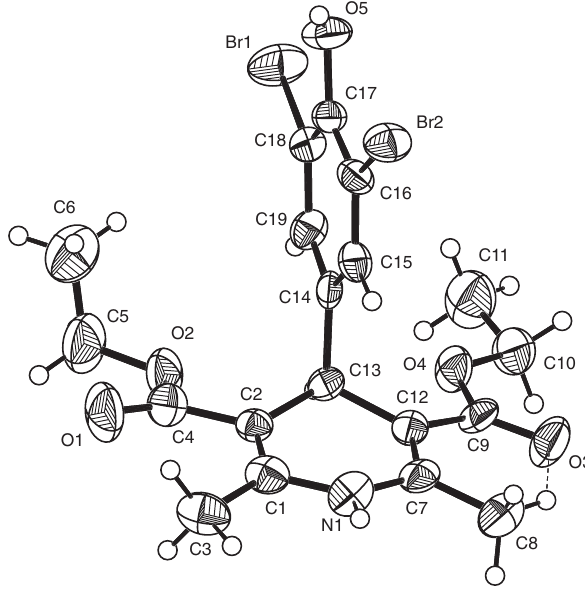
Table 1: Data collection and handling.